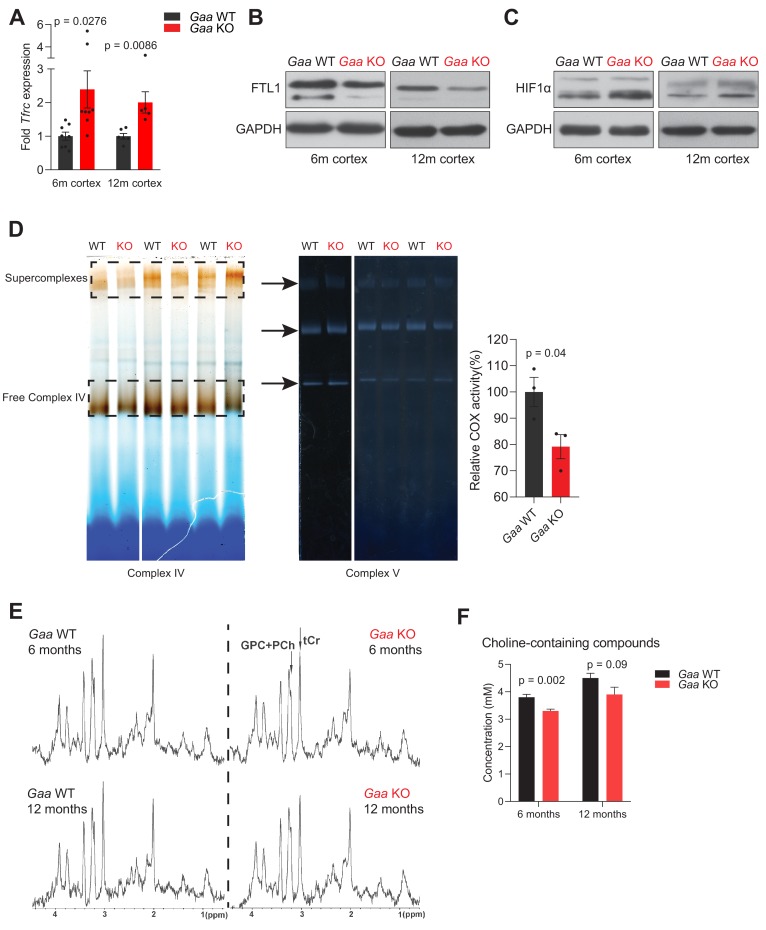
Functional iron deficiency in a mouse model of impaired lysosomal acidification (Gaa-/- mouse).(A) Tfrc mRNA levels in the cortex of 6 and 12 month old Gaa-/- mice and their wild type littermate controls. Black dots represent sample size (n) in each group. p values are unpaired two-tailed t-tests with Welch’s correction. Bars are depicted as mean ± SEM. (B) Western blot of FTL1 and GAPDH as loading control from cortical tissue lysates of 6 and 12 month old Gaa+/+ and Gaa-/- mice (n = 4 mice per group). (C) HIF-1α immunoblots with GAPDH as loading control from cortical tissue lysates of 6 and 12 month old Gaa+/+ and Gaa-/- mice (n = 4 mice per group). (D) Activity staining of native respiratory chain complex IV of mitochondria purified from cortices of 6 month old mice (n = 3; depicted as black dots). Complex V activity staining is used as loading control. The difference between activities (mean ± SEM) of groups is determined by the unpaired two-tailed t-test with Welch’s correction. (E) MRS reveals significant changes in metabolite concentrations in Gaa-/- mice in vivo. MRS (STEAM, TR/TE/TM = 6000/10/10 ms, 256 averages, (2.0 mm)3 volume-of-interest centered on the striatum) of 6 month old (upper row) and 12 month old (lower row) wild type (right column) and Gaa-/- mice (left column) in vivo, as summarized in Table 1, processed with a 1 Hz line broadening. GPC+PCh = Choline containing compounds, tCr = total creatine, ↑=significant signal intensity increases, ↓=significant signal intensity decreases. *p<0.05; **p<0.01, Mann-Whitney’s U-test. (F) Graphs depicted as mean ± SEM of n = 8 mice per group (6 months) or five mice per group (12 months) show decreased concentration of total choline-containing compounds in Gaa-/- mice in vivo. p values indicate the Mann-Whitney’s U-test.